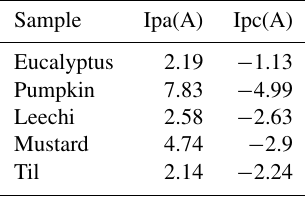
Table 2. Cathodic and anodic peak current observed for the ZnONPs modified CPs electrode of each floral type of honey.